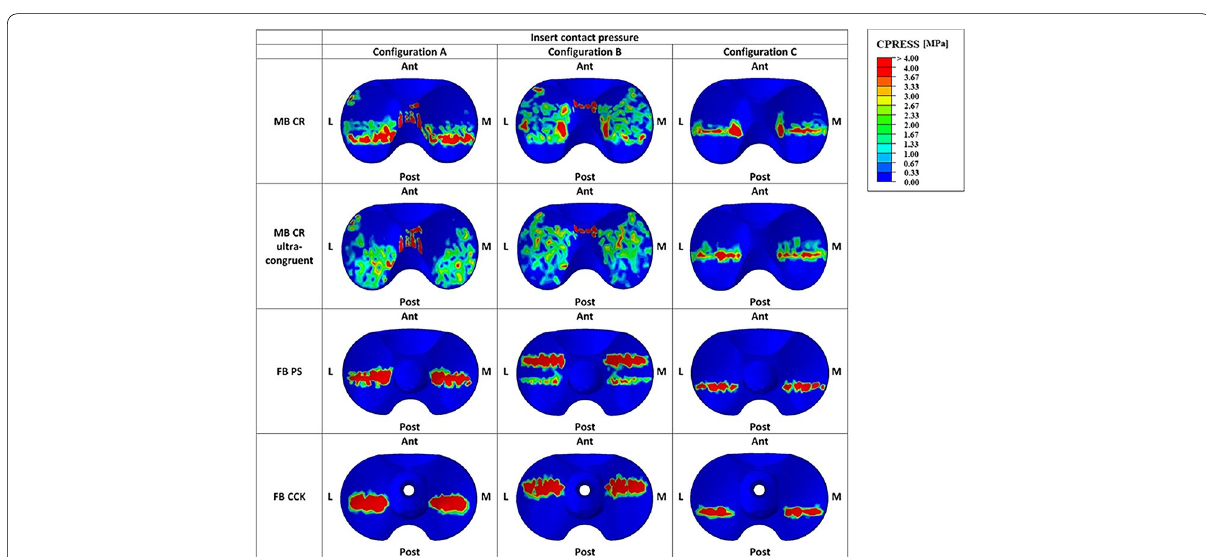
Fig. 7 Qualitative overview of the insert contact pressure in the three studied configurations (M